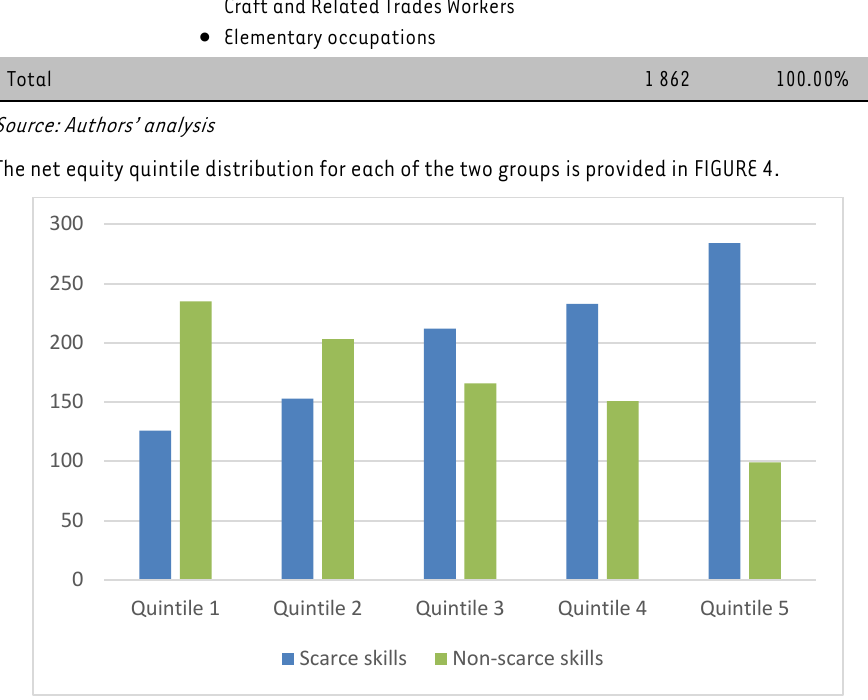
FIGURE 4: Net equity quintile distribution of scarce skills and non-scarce skills occupations